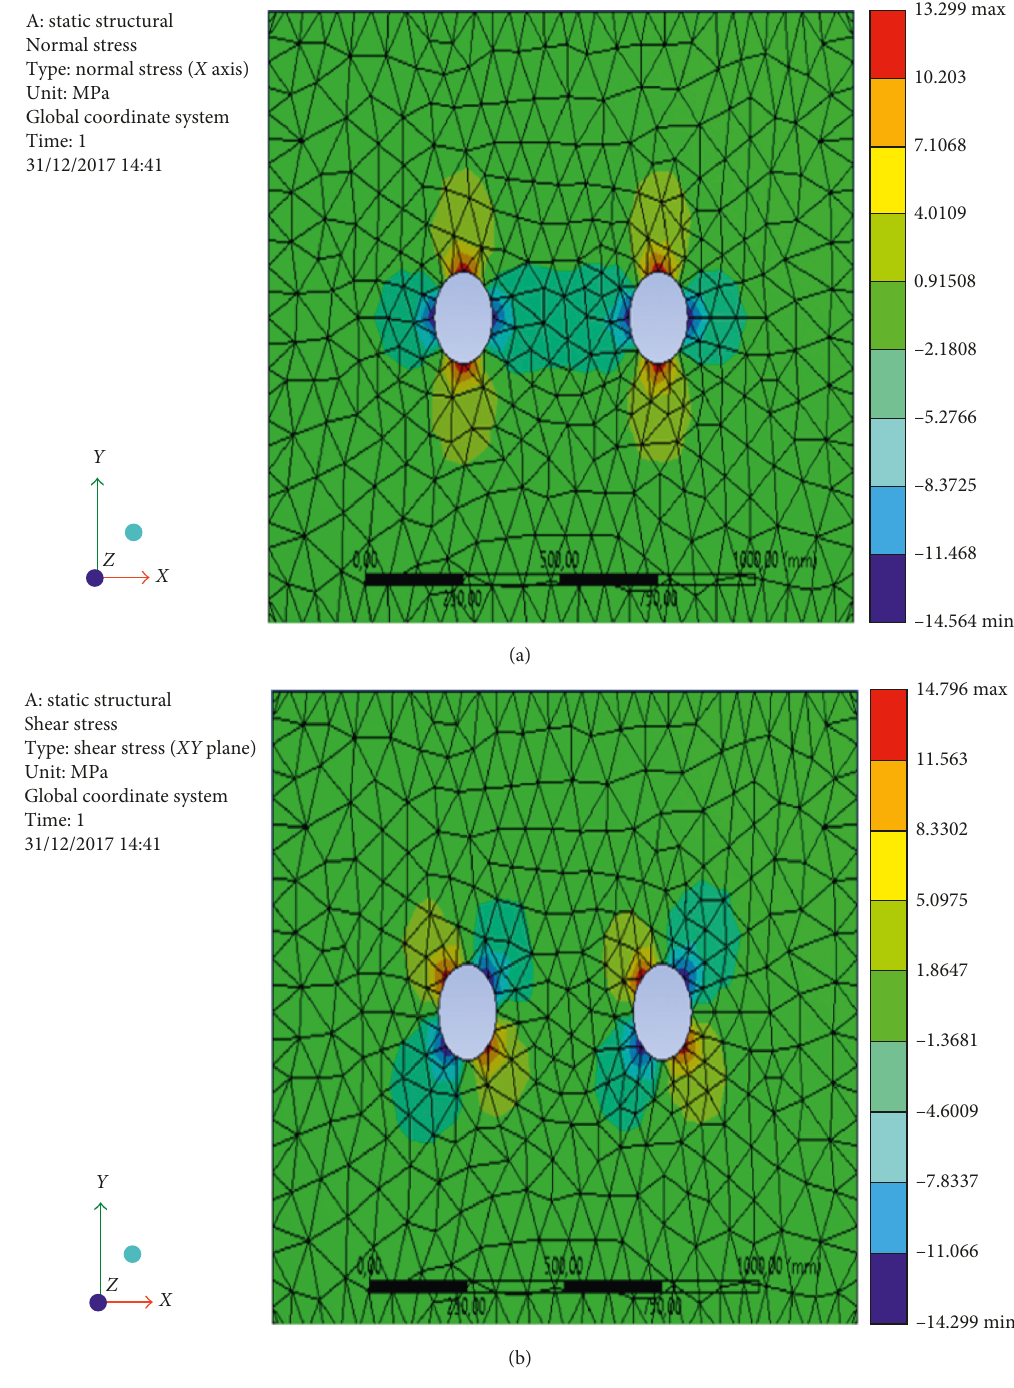
Figure 8: Redistribution of (a) normal stress and (b) tangential